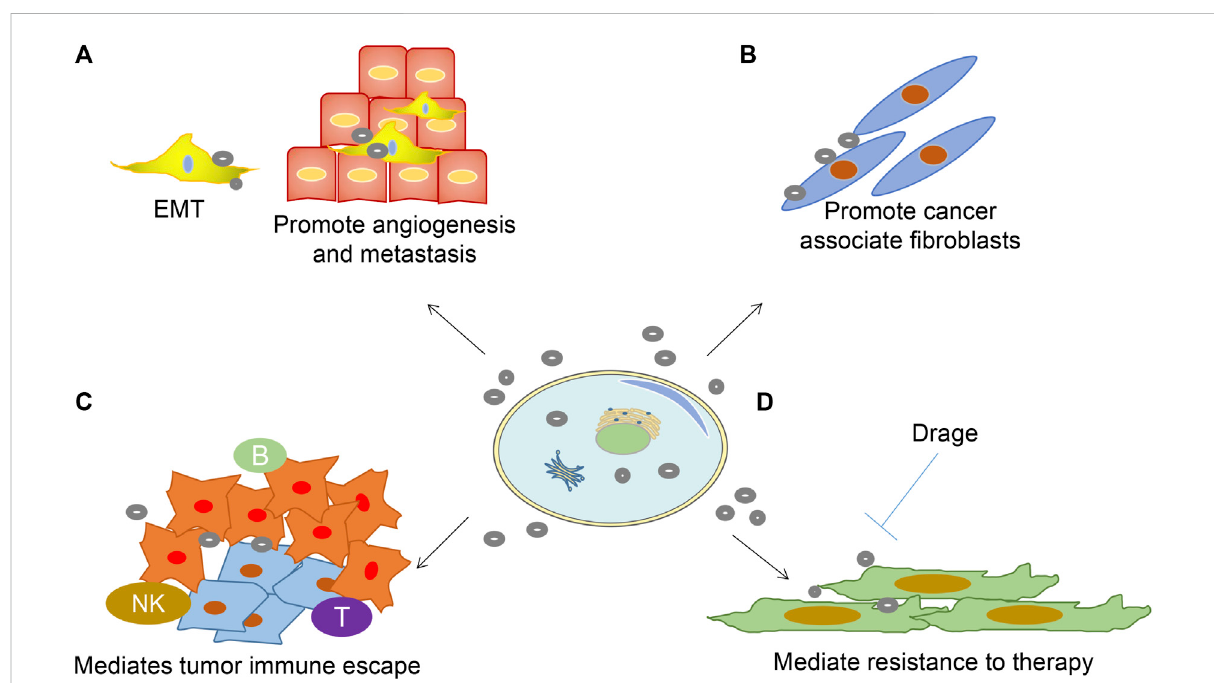
FIGURE 2 Role of EVs in sustaining cancer resistance networks. (A) EVs-released factors can promote EMT cell morphology, causing stemness and promoting angiogenesis; (B) Promote fi broblast-like cell formation that causes a desmoplastic reaction (stromal reaction); (C) Promote immune escape mechanisms; (D) EVs mediated resistance to